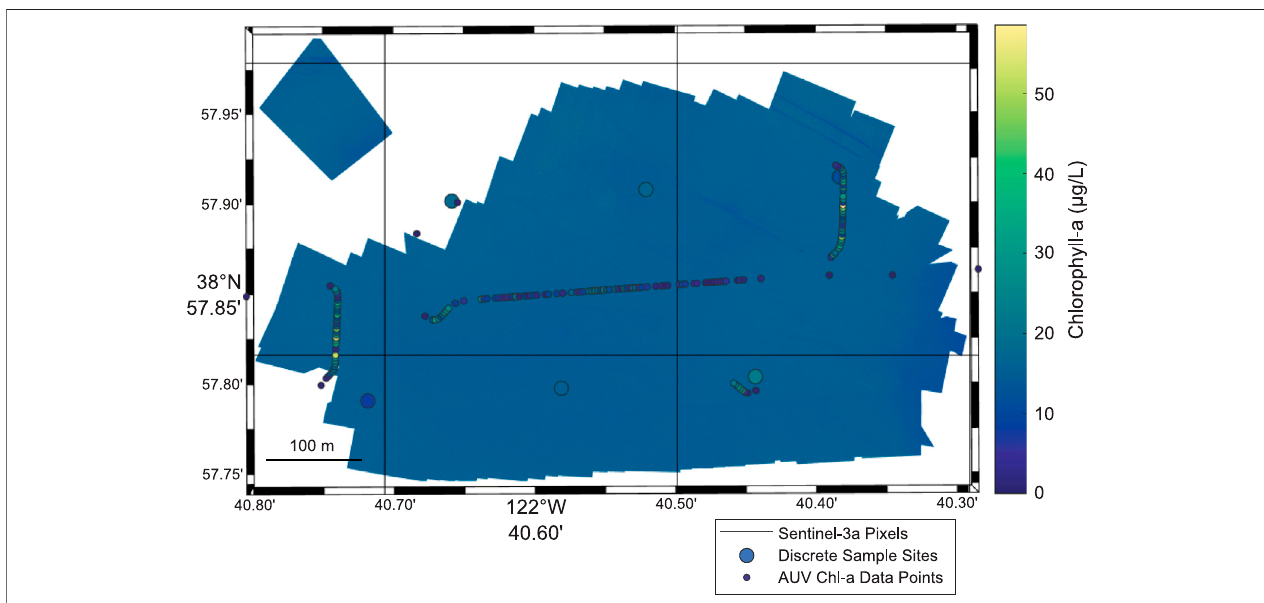
FIGURE 8 | Concurrent measurements of cyanobacteria bloom in the Lower Arm of Clear Lake (site CL03) on August 16, 2019. Variability is observed in the chlorophyll- a measurements between the different sampling platforms. Also, there is high intra-pixel variability of the chlorophyll- a measurements. Image includes grab sample chlorophyll- a observations (large circles), AUV chlorophyll- a measurements (small circles), and sUAS-derived chlorophyll- a as background image. Sentinel-3a satellite pixels shown as dark grey